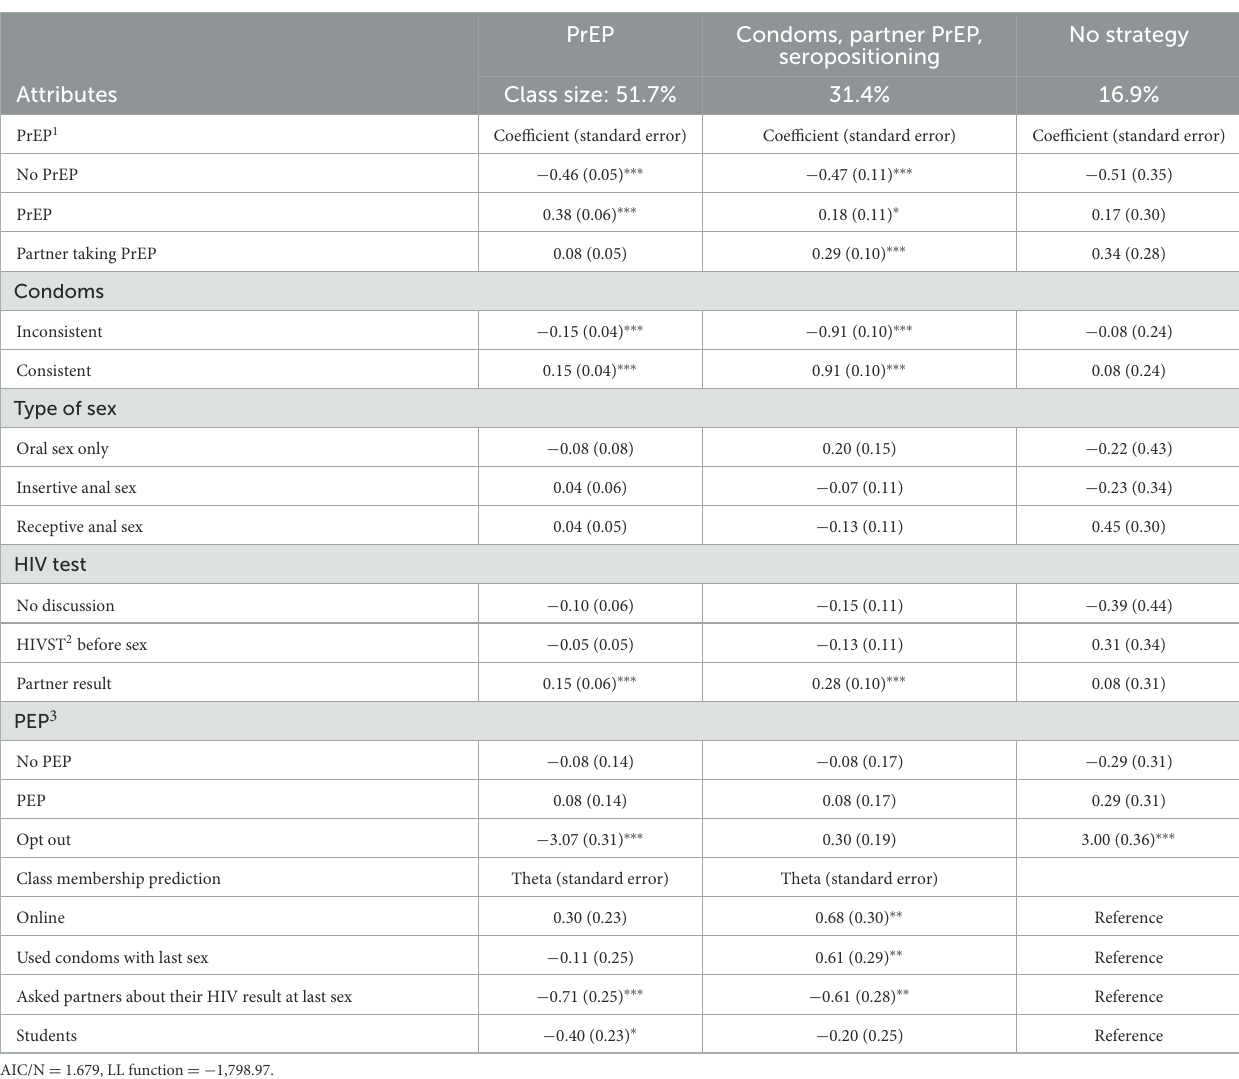
TABLE 4 Latent class analysis for HIV prevention